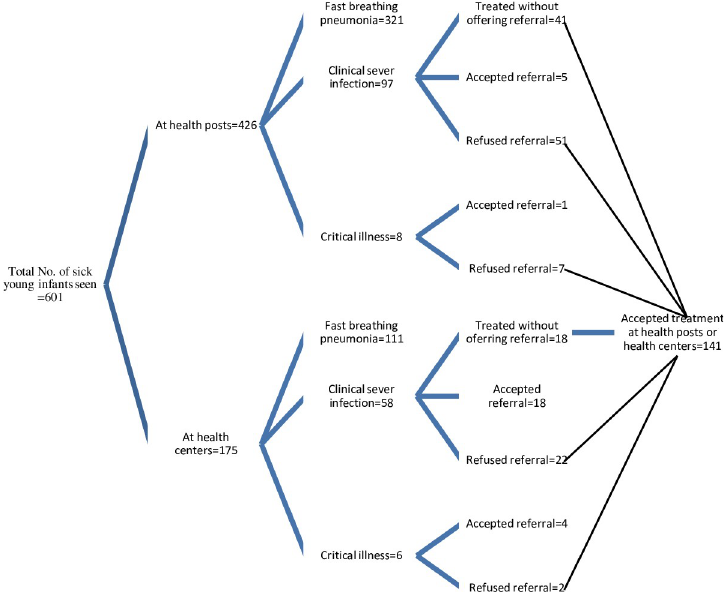
Fig 1. Number of infants with any sign of PSBI assessed, classified and managed at different levels of health facility.